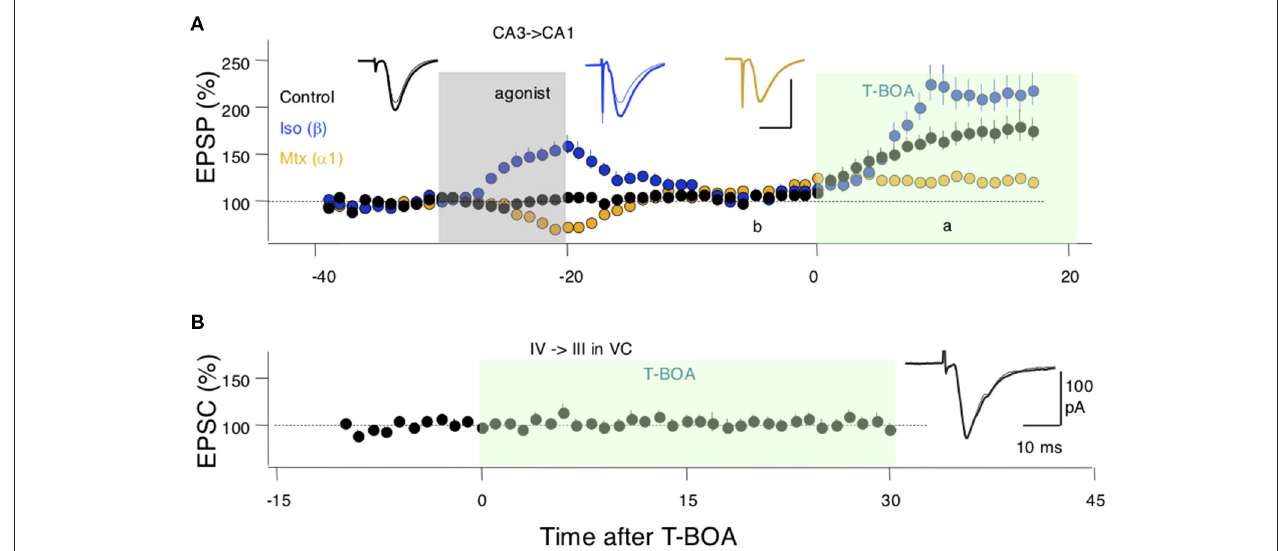
FIGURE 4 | Evidence for an adrenergic modulation of a perisynaptic pool of AMPA receptors (AMPARs). (A) In SC-CA1 synapses of the hippocampus bath application of a glutamate uptake blocker (T-BOA: 10 µ M. green box) enhances the synaptic responses (black symbols). Pretreating the slices with the agonist for β -adrenergic receptors (coupled to Gs) isoproterenol (Iso: 10 µ M for 10min) potentiates the effects of T-BOA. In contrast, pretreating with an agonist for the a1 adrenergic receptor (coupled to Gq) methoxamine (Mtx: 5 µ M for 10min) reduces the enhancement induced by T-BOA. (B) In the visual cortex, T-BOA does not affect synaptic responses suggesting that the pool of perisynaptic AMPARsis too small to be detected. Traces in (A,B) are averages of 10 consecutive responses recorded 10min. before (B) and 10min. after (A) the addition of T-BOA. Each symbol in (A,B) represents data normalized as % of pre-TBOA baseline and averaged over